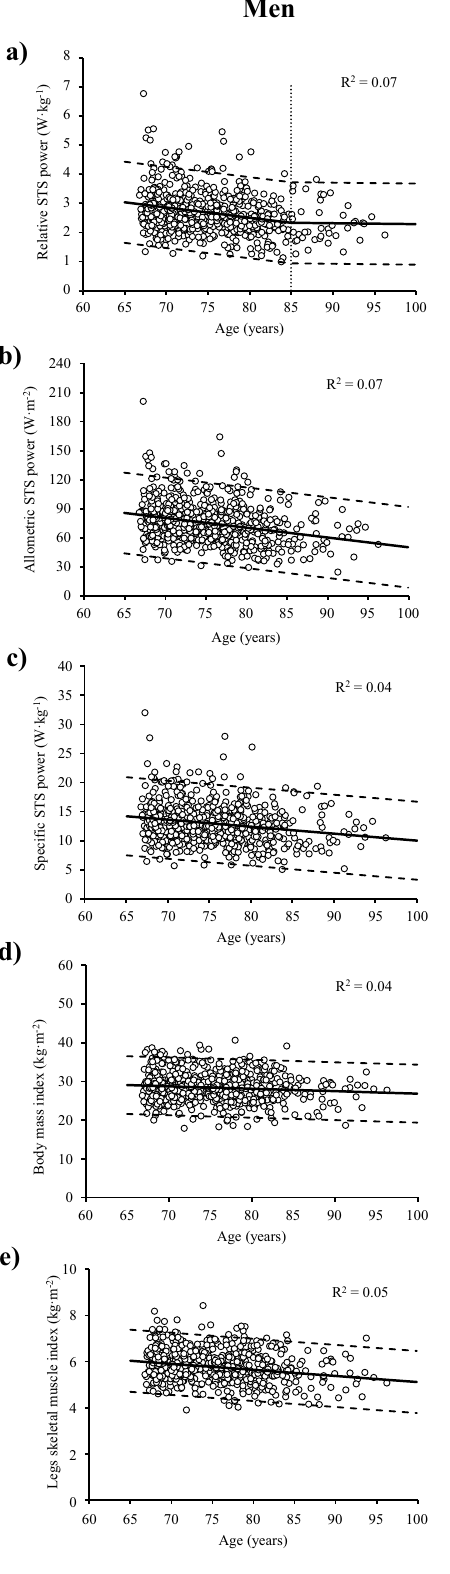
Figure 1. Association between age and relative ( a ), allometric ( b ) and specific STS power ( c ), body mass index ( d ) and legs skeletal muscle index ( e ). Regression lines (continuous lines), 95% confidence intervals (dashed lines), age at which a significant change in slope occurred (dotted lines) and coefficient of determination (R 2 ) values obtained from piecewise regression